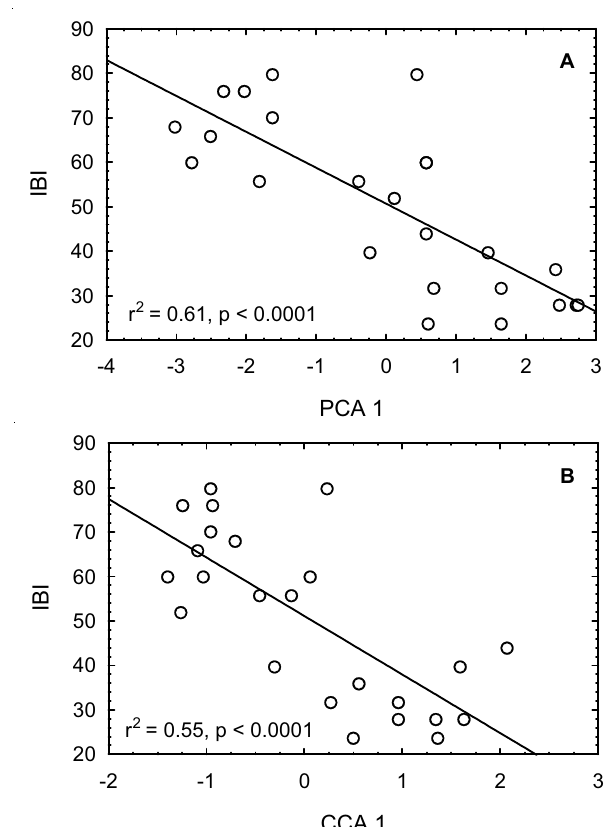
Fig. 6. The correlations of the PCA 1 and CCA 1 axes with the index of biotic integrity explain with moderate correlation and high significance the recognizable variations in the